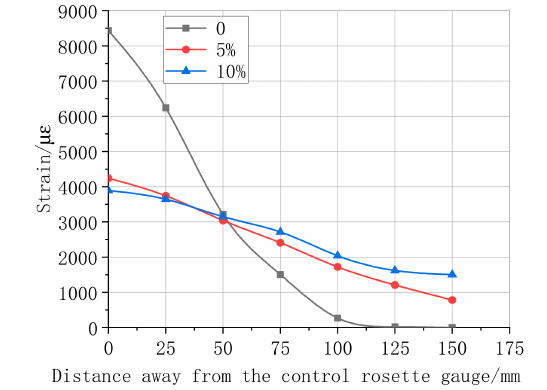
Figure 14. Ultimate strain of CFRP length 350 mm under di ff erent